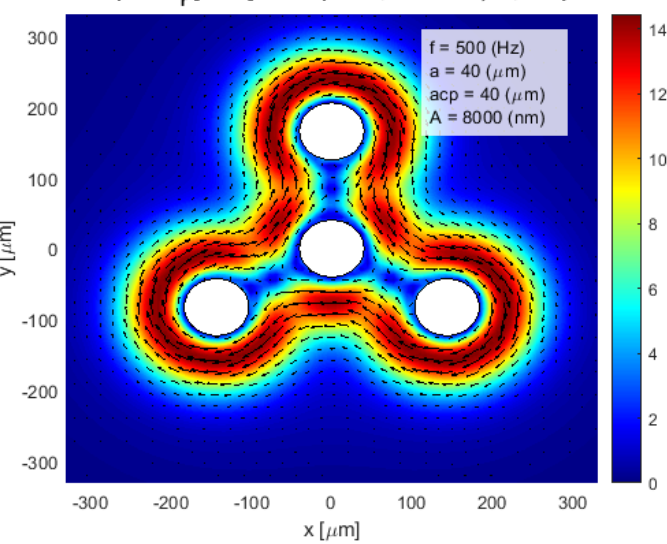
Figure 5. Rotational velocity of water stream 𝑣 𝑟 in a more complex layout. An even more complex layout of 15 pillars which would be suitable for streaming of water inside an open pot-like layout of the pillars’ configuration is presented in Figure 6. The inner diameter of the pot-like shape of pillars is D = 500 µm.